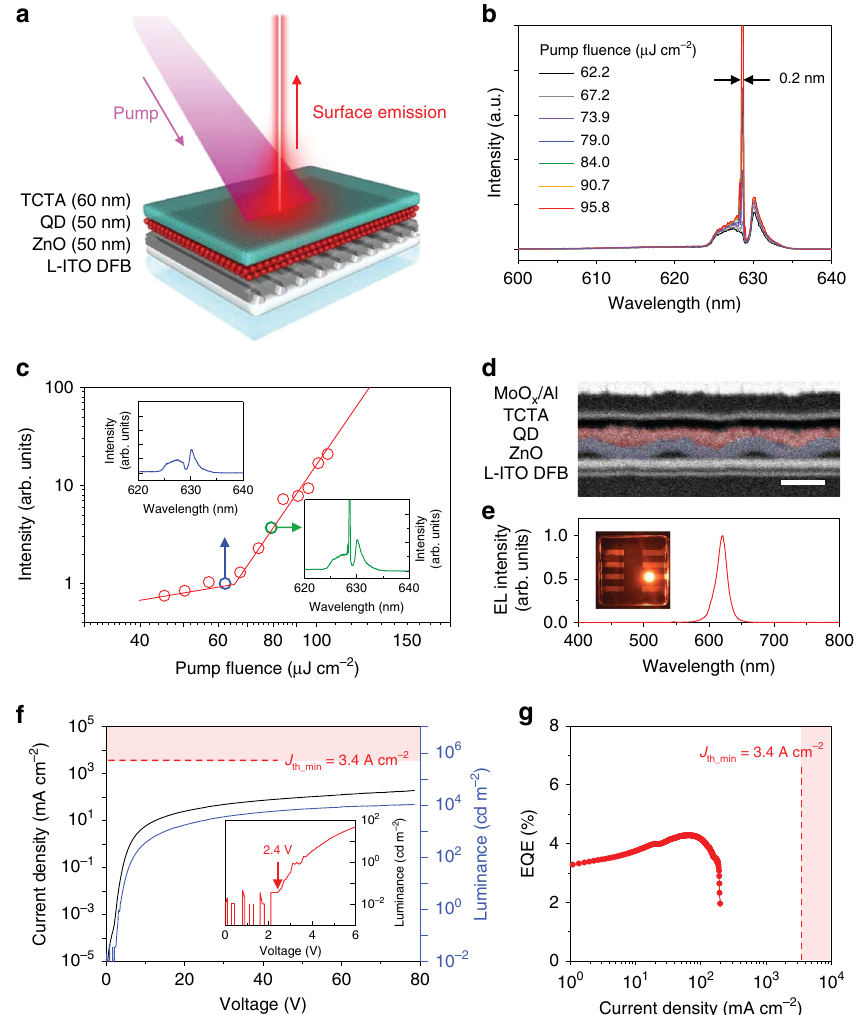
Fig. 4 An LED-like device which performs as both an optically pumped single-mode laser and an electrically excited emitter. a Schematic illustration of an optically pumped multilayered DFB laser employing the same device architecture as a traditional p-i-n QD-LED. b Surface emission spectra on this device as a function of pump fl uence display a clear transition to single-mode lasing at 629 nm. c Based on the onset of steep growth of the emitted light intensity, the lasing threshold is 65 µ J cm − 2 . Inset displays dramatic increase in emission intensity and line narrowing above the lasing threshold. d The cross-sectional SEM image of the EL device. To study EL, the device shown in a is supplemented by a hole-injecting electrode made of MoO x (10 nm thickness) followed by Al (100 nm thickness). The scale bar is 200 nm. e The EL spectrum peaks at 621 nm. Inset: a photograph of an operating device, which shows that EL is highly uniform across the active area (0.15 × 0.15 cm 2 ). f Current-density (luminance) versus voltage characteristics of the EL device; shaded area is the range of current densities where the QDs are expected to exhibit optical gain. Inset shows that the turn-on voltage of the EL device is ~2.4 V. g Device EQE as a function of current density indicates a peak EQE of 4.3%; the meaning of the shaded area is the same as in f . Source data are provided as a Source Data fi